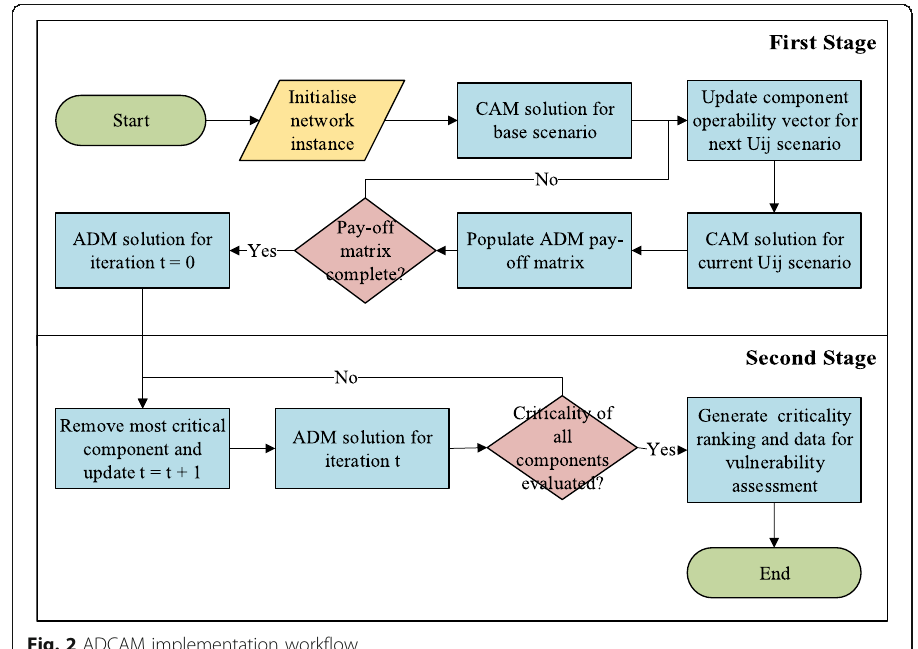
Fig. 2 ADCAM implementation